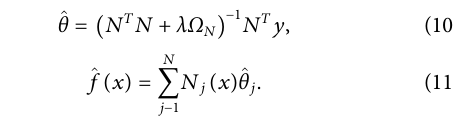
FIGURE 3 The IC curves of batteries N1, N2, and